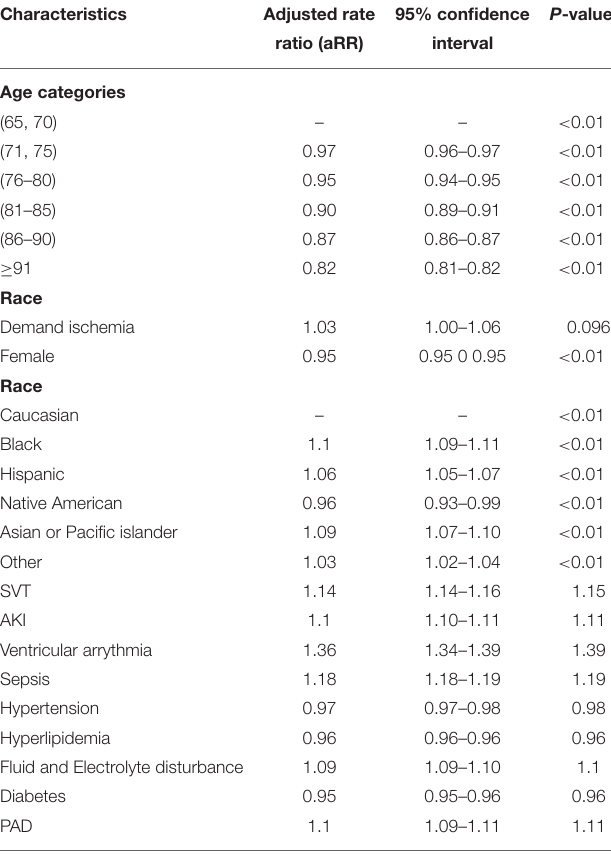
TABLE 4 | Association between demand ischemia and length of stay in survivors without either non-cardiogenic shock or mechanical ventilation adjusting for demographics and clinically relevant